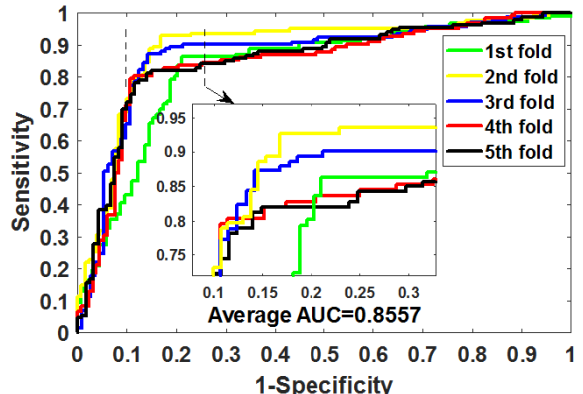
Figure 5. ROC curves of the 5FCV experiment acquired by RoFDT on the GPCR dataset.